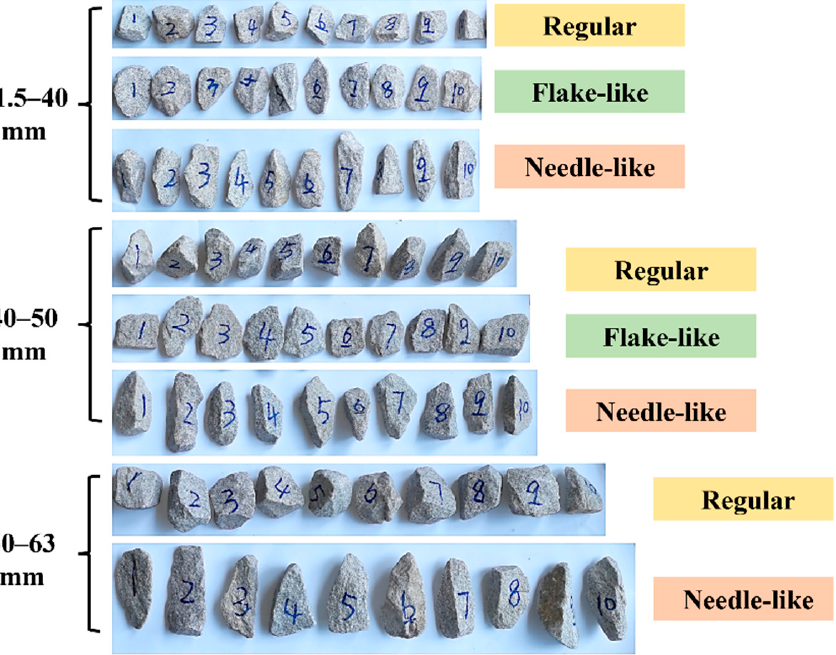
Figure 4. Illustration of example ballast particles of different shape categories and size ranges. Table 1. The impact-load-test matrix for single-size ballast particles.